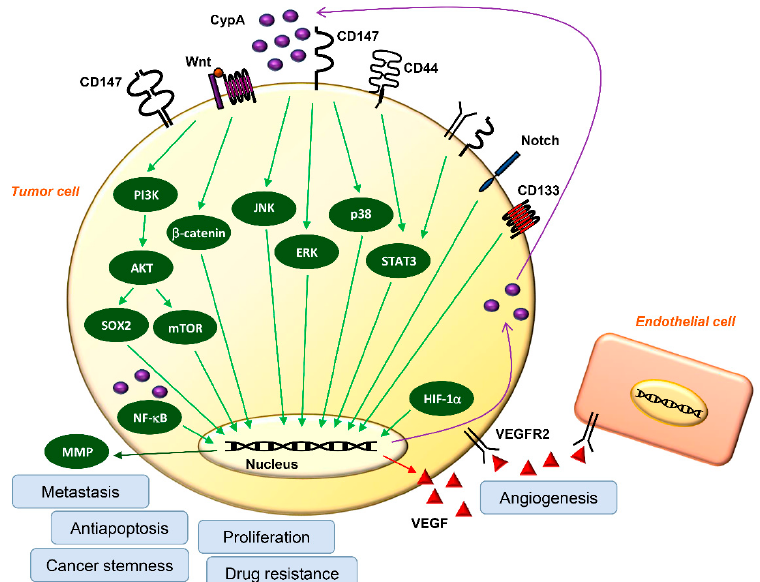
Figure 4. Major oncogenic signaling pathways regulated by CypA/CD147 axis. CypA expression can be regulated by HIF-1 α and interacts with its receptor CD147 through autocrine/paracrine extracellular secretion. The CypA/CD147 interaction can activate directly or indirectly multiple oncogenic signaling pathways, including PI3K/AKT, Wnt/ β -catenin, MAPKs, STAT3, Notch, and NF- κ B, thereby promoting proliferation, antiapoptosis, metastasis, angiogenesis, drug resistance, and stemness of cancer